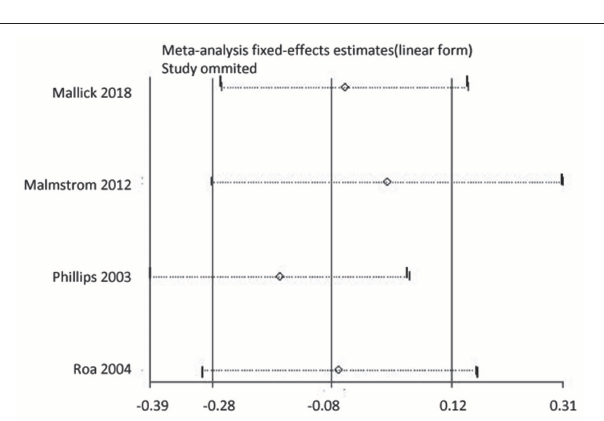
FIGURE 5 | A sensitivity analysis by omitting any single study for overall